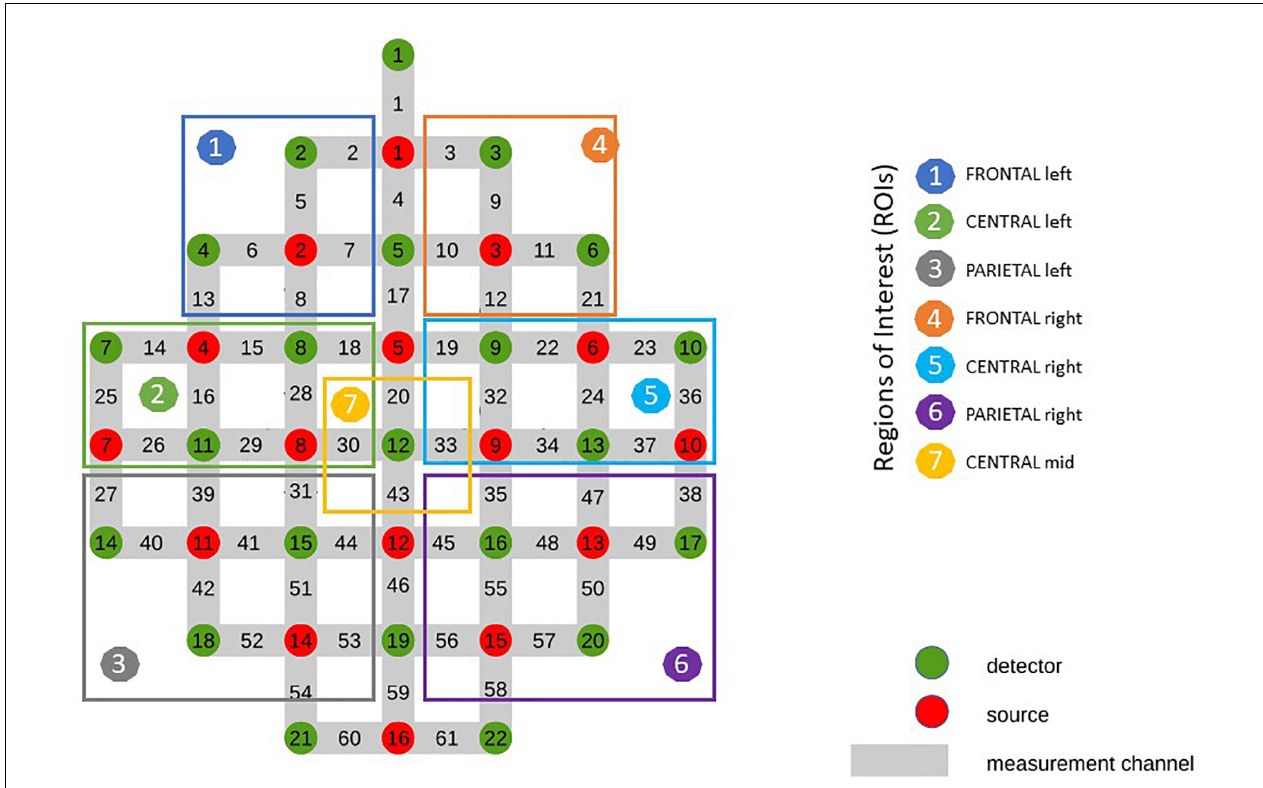
FIGURE 2 | Optode Montage and Regions of Interest